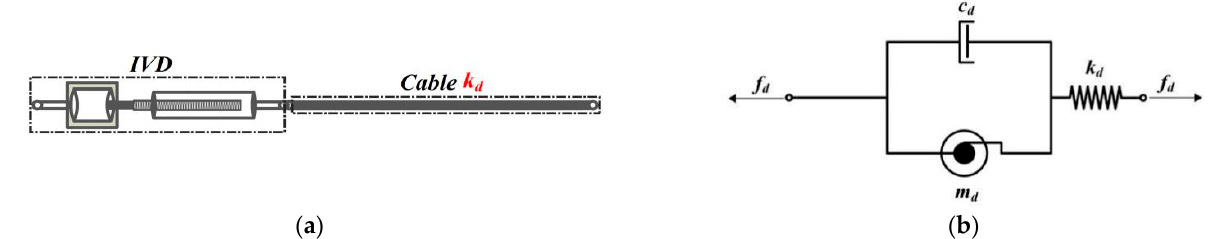
Figure 3. Mechanical model of a cable inerter viscous damper (CIVD): ( a ) Structure of CIVD; ( b ) and mechanical model.